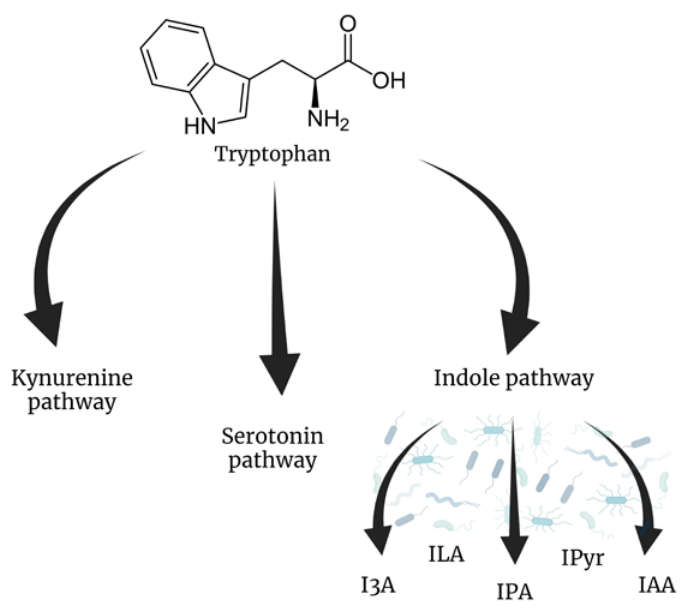
Figure 1. Three pathways of tryptophan metabolism. The indole pathway is mostly associated with intestinal microbiota metabolism. Various compounds produced in this pathway are considered beneficial to human health. I3A—indole-3-aldehyde, ILA—indole lactic acid, IPA—indole propionic acid, IPyr—indole pyruvate, IAA—indole acetic acid. Created with